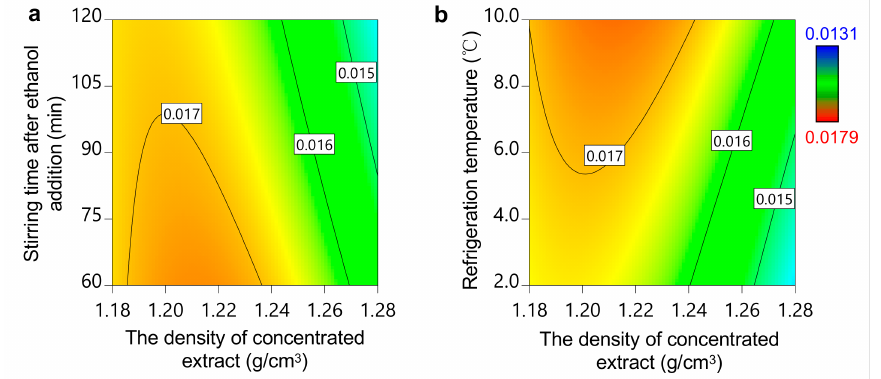
Figure 9. Contour plot of the purity of total flavonoids. ( a ) Ethanol concentration was 95%, ECR was 2.8 v / v , refrigeration temperature was 6 ◦ C. ( b ) Ethanol concentration was 95%, ECR was 2.8 v / v , stirring time after ethanol addition was 90